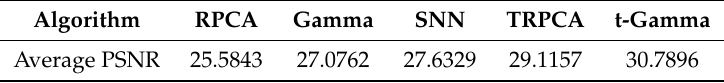
Table 1. Average PSNR obtained by five Algorithms on 200 images.